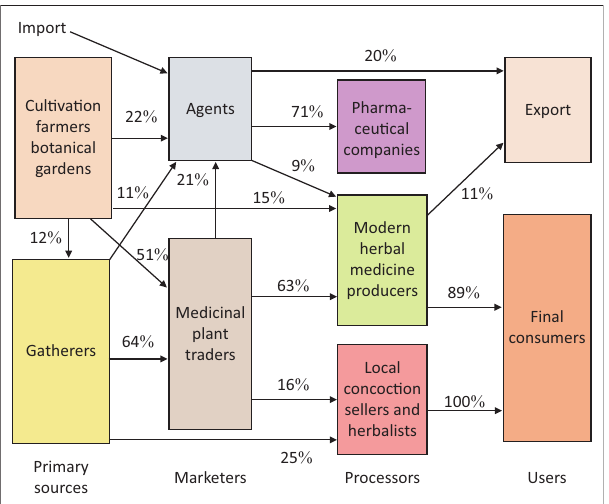
FIGURE 2: Supply chain of medicinal plants in Kwara State.